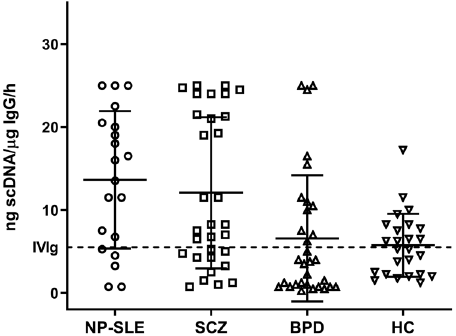
Fig. 5 Comparative analysis of IgG mediated DNA hydrolysis. IgG (1 µg) was incubated with plasmid DNA (50 ng) for 1 h at 37 °C and hydrolysed products were analysed on 0.8% agarose gel. scDNA hydrolysis was determined and calculated by densitometry analysis (Image Lab TM 6.0.1, Bio-Rad). One-way ANOVA analysis revealed a signi fi cance between the groups with F (3, 103) = 6.792, p = 0.0003. IVIg (-----), NP-SLE neuropsychiatric systemic lupus erythematosus ( n = 20), SCZ schizophrenia ( n = 31), BPD bipolar disorder ( n = 31), HC healthy control ( n = 25). F (3,103) = 6.792. Based on the central tendency value (mean ± sd) highest DNase activity, as expected, was noted in NP-SLE (13.6 ± 8.7) and successively followed by SCZ (12.1 ± 9.2), BPD (6.5 ± 7.6) and healthy control (5.7 ± 3.7). Of further interest, the immunological analysis revealed a low titre of anti-dsDNA Abs in both SCZ and BPD patients on contrary to NP-SLE patients (Table 2). Both the IL-6 and IgG levels exemplify